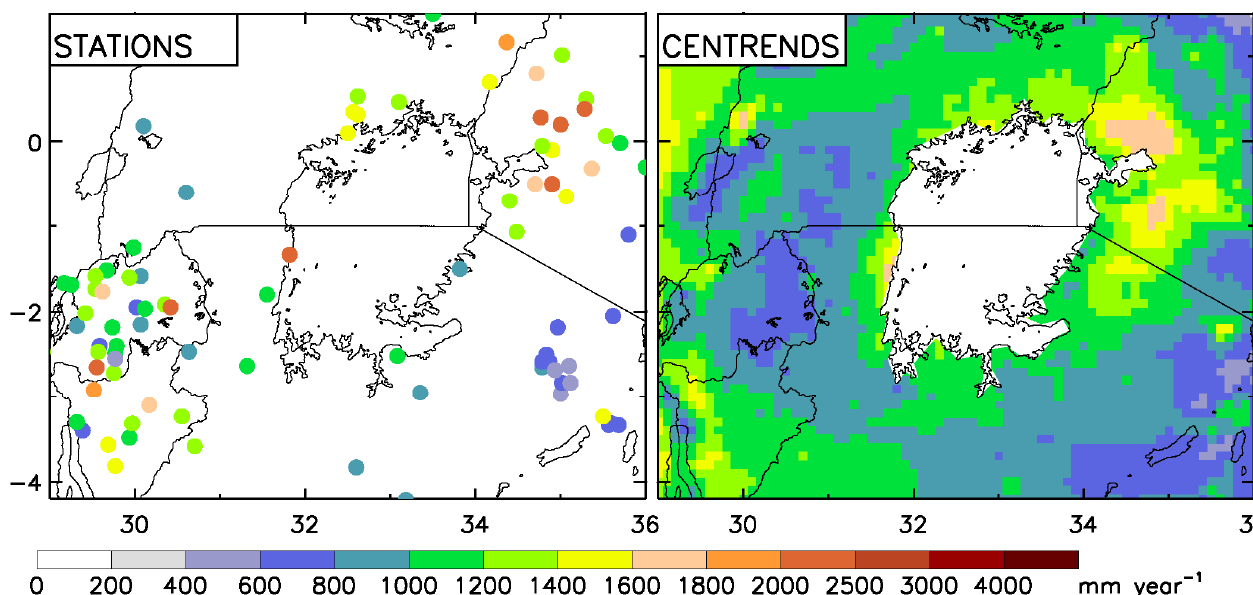
Figure 9. Mean annual rainfall (mm) from NIC131 (2001 to 2018) and CenTrends (2001 to 2014).